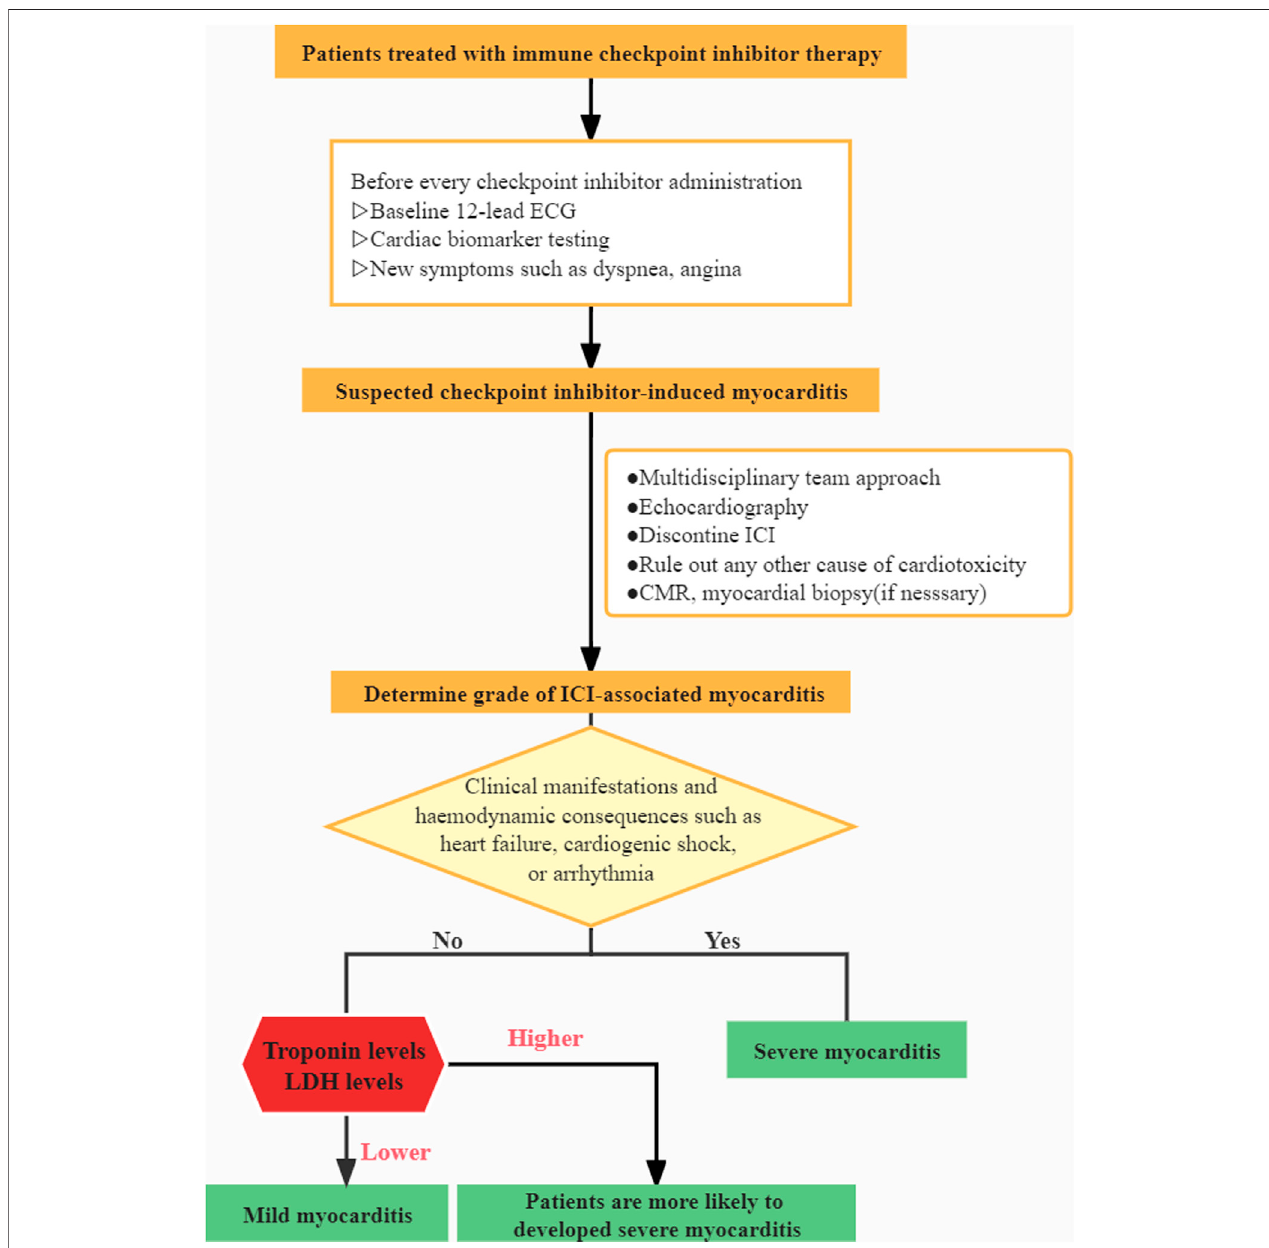
FIGURE 3 | Algorithm for the management of immune-related